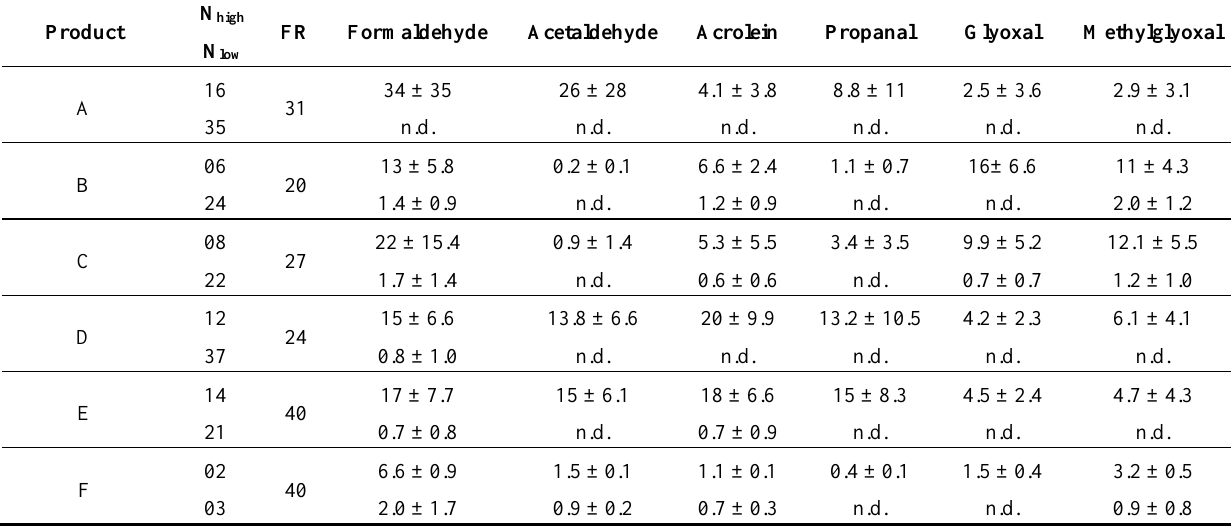
Table 1. Amounts (μg/10 puff) of major carbonyl compounds generated from 13 brands of Japanese e-cigarettes. Smoking machine was performed at 10 puffs (reproduced from [13] with permission from The Japan Society for Analytical